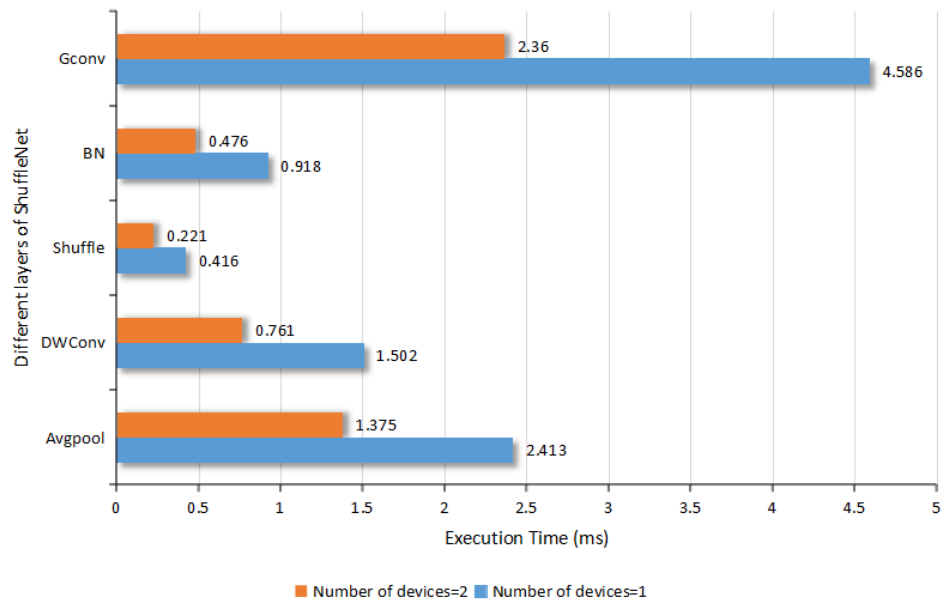
Figure 6. Comparison of computing time of different layers of I-ShuffleNet . The resources used for the entire network inference process are shown in Table 4.